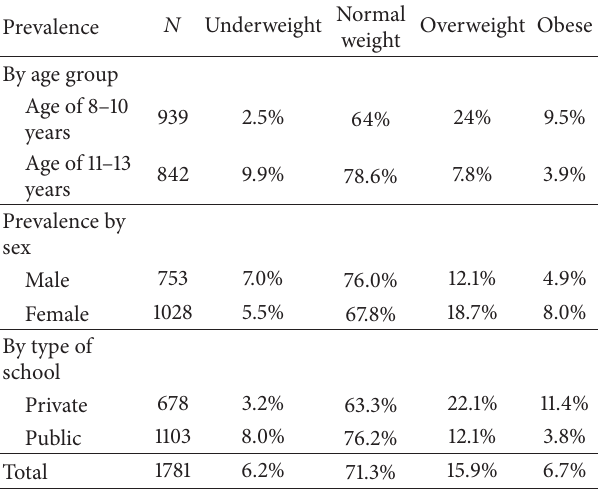
Table 1: Prevalence of underweight, overweight, and obesity among ).